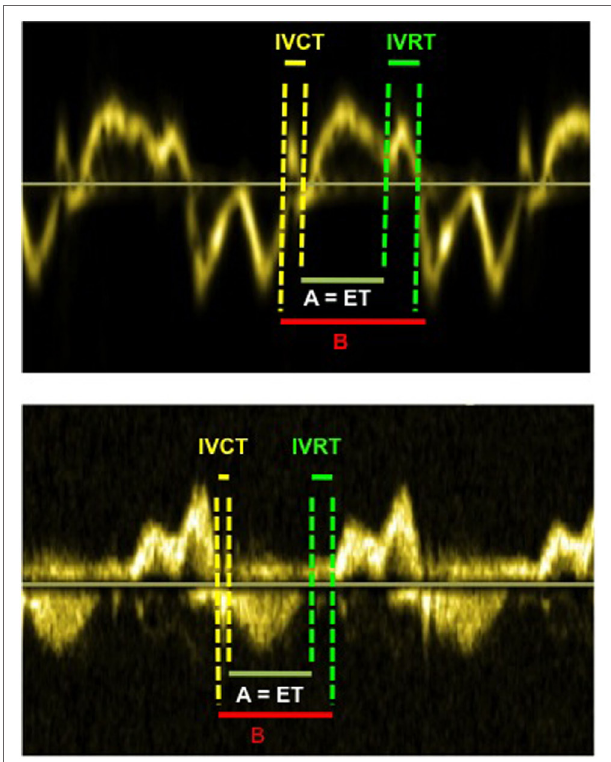
FigURe 6 | Myocardial performance index ( = MPI or Tei index) obtained from tissue Doppler (above image) and from Doppler (below image). The MPI is calculated as the (IVCT + IVRT)/ET or (B − A)/A. The MPI allows evaluation of systolic and diastolic ventricular function. Abbreviations: ET, ejection time; IVCT, isovolumetric contraction time; IVRT, isovolumetric relaxation time.